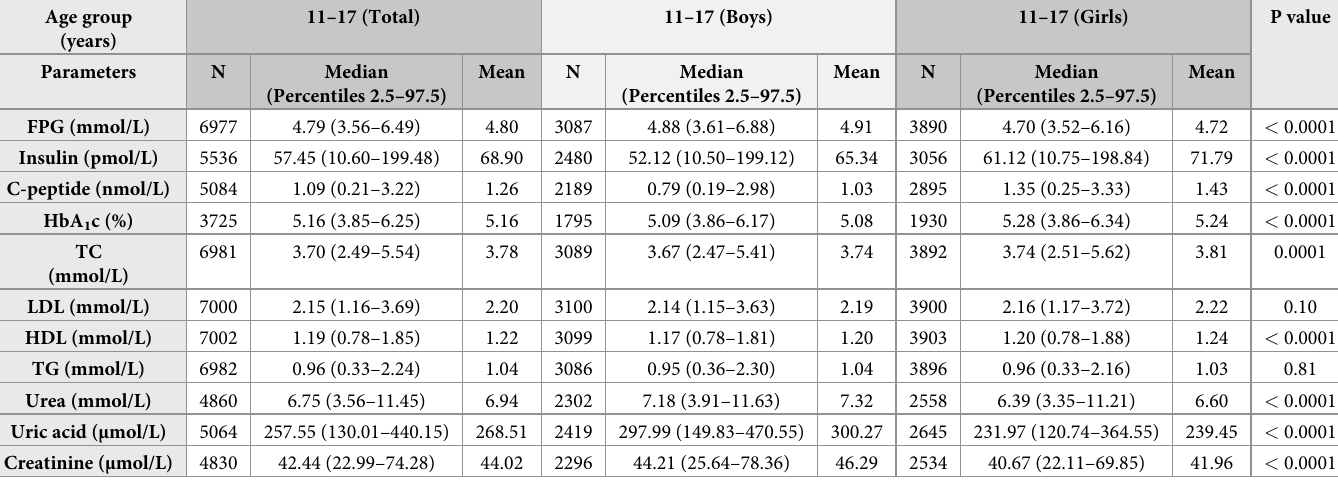
Table 1. Normative range of common biochemical parameters in Indian